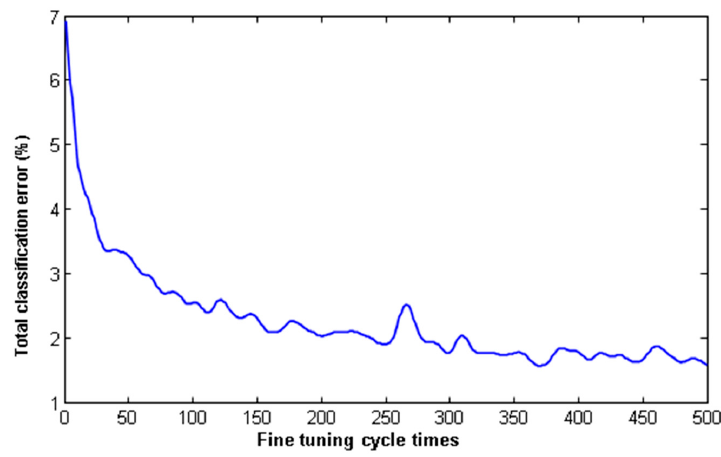
Figure 13. The total error of classification varies with the number of cycles.